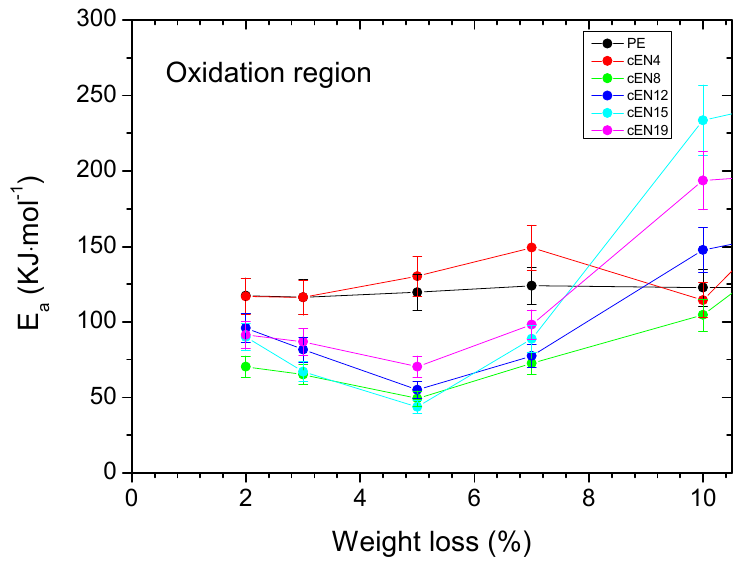
Figure 8. Activation energies associated with the weight loss (bars correspond to a relative error of 10%).